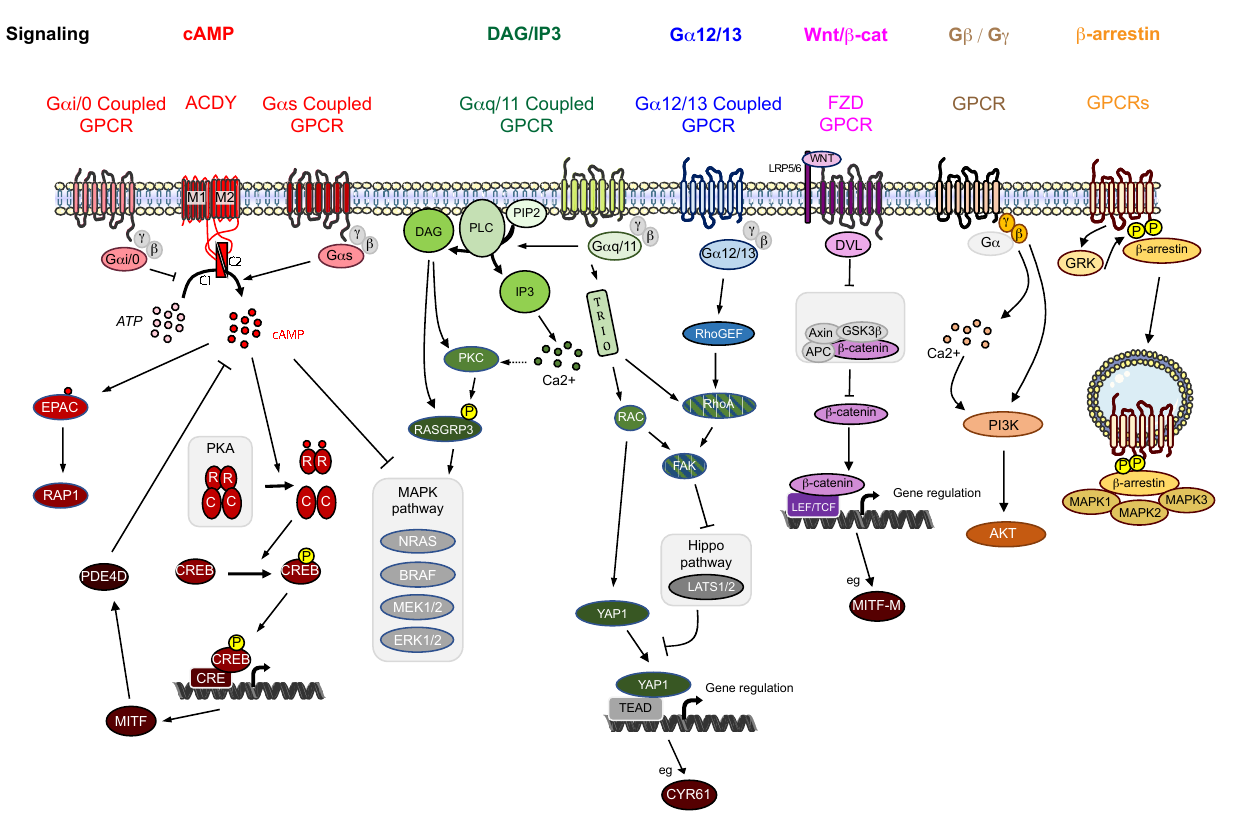
Figure 1. GPCR signaling pathways. Note that the G α q/11 et G α 12/13 G-proteins share a common downstream signaling